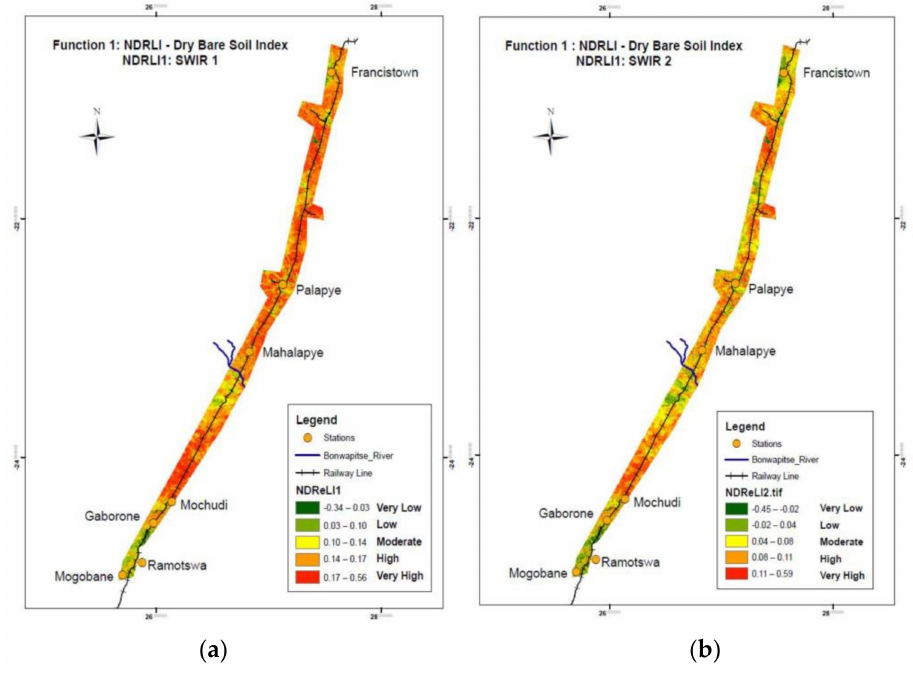
Figure 11. NDRLI based on: ( a ) SWIR1 and ( b ) SWIR2.